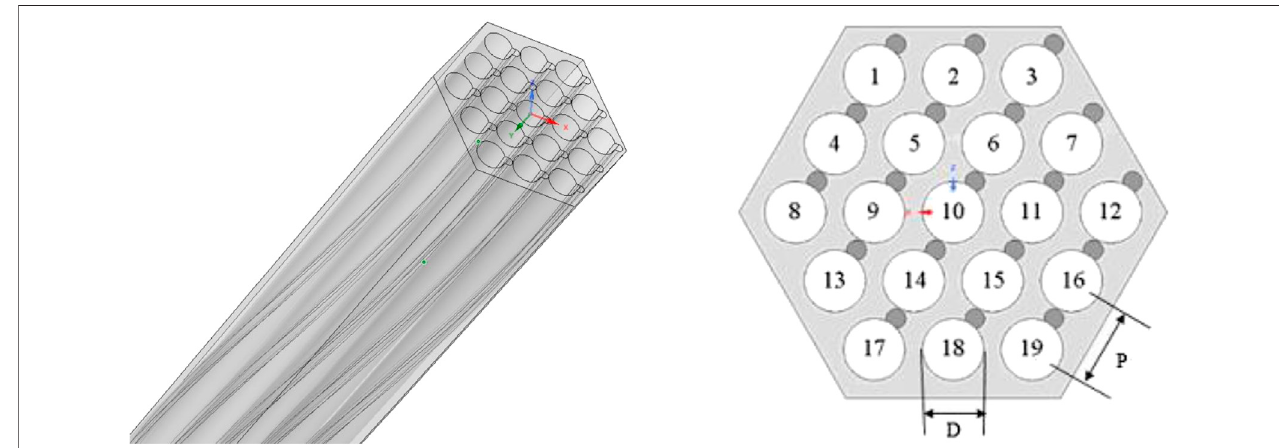
FIGURE 1 | The three dimensional model of the computational domain.